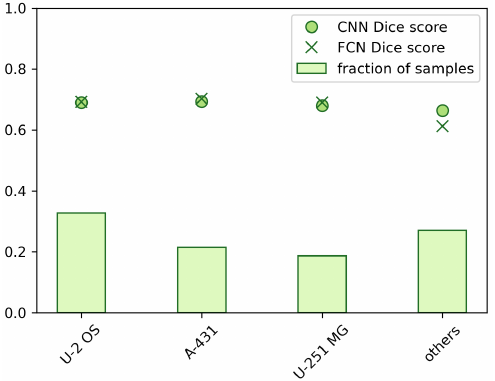
Figure 8. Classification accuracies using the dice coefficient presented separately for samples from the three major cell lines and combined for samples from the other cell